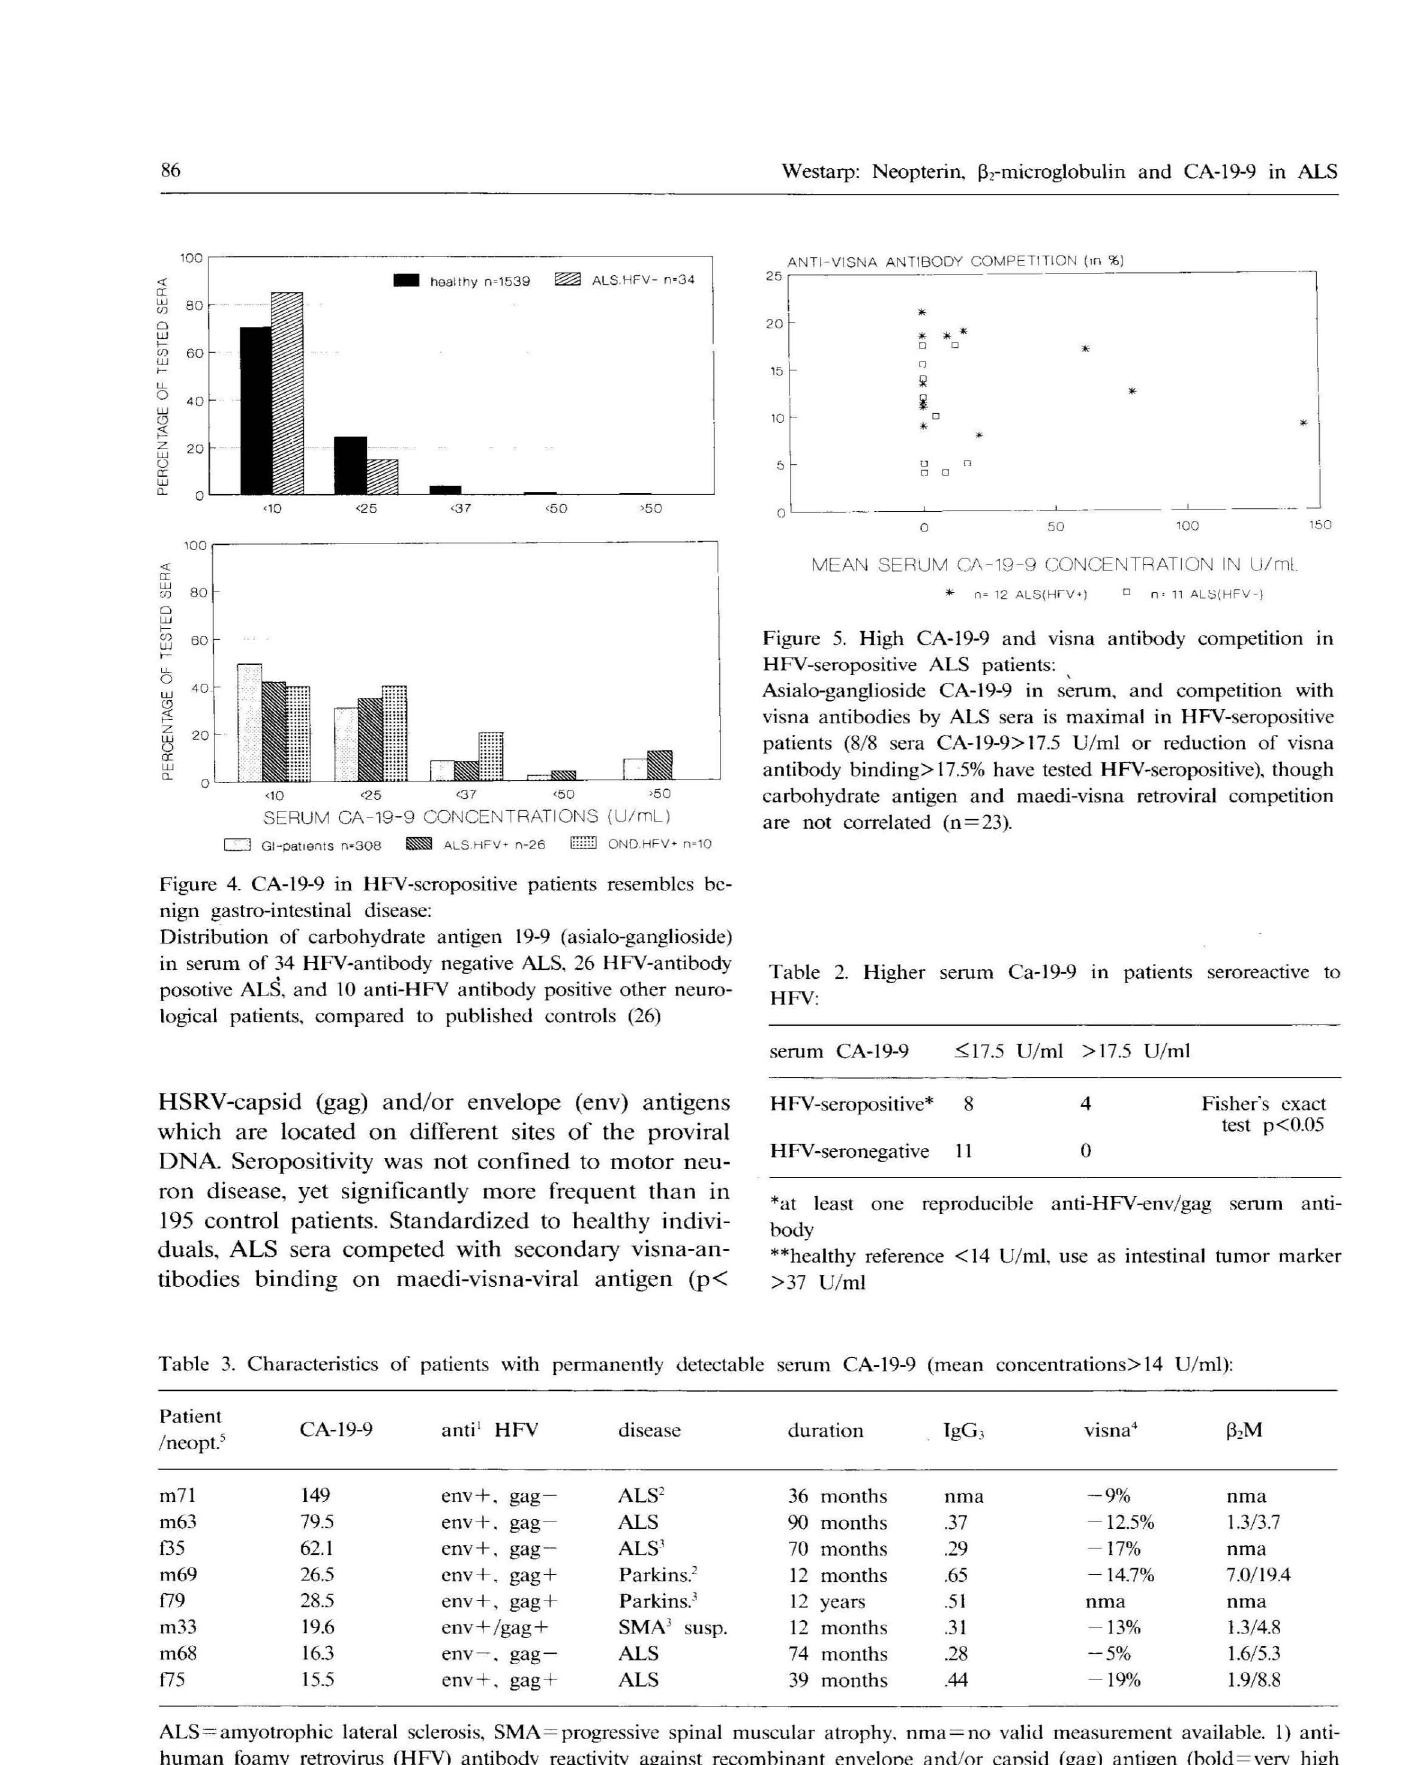
ALS=amyotrophic lateral sclerosis. SMA=progressive spinal muscular atrophy. nma=no valid measurement available. I)